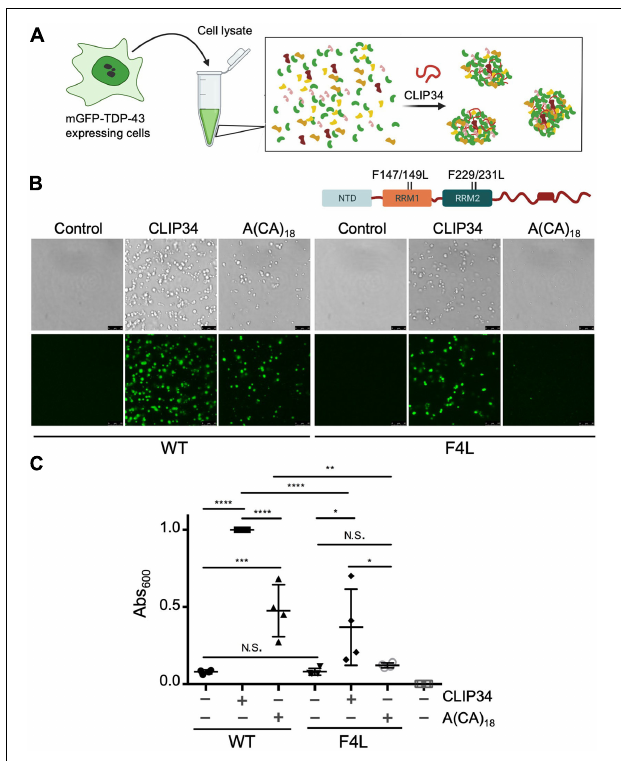
FIGURE 2 | CLIP34 RNA promotes TDP-43 condensation in a cellular lysate. (A) Cell lysates prepared from HEK293 cells stably expressing a single mGFP-tagged copy of either wild-type (WT) or F147/149/229/231L (F4L) TDP-43. Recombinant TDP-43 (WT or F4L, 5.3 µ M) was added to the cell lysate at 250 mM NaCl, pH 7.5. Samples were mixed with CLIP34 (7.6 µ M), A(CA) 18 (7.6 µ M), or no RNA control. (B) Condensates were imaged by brightfield and fluorescence microscopy. Representative images of 3 biological replicates from 2 protein preparations. Scale bars, 10 µ m. (C) Phase separation of TDP-43 in cell lysates measured by turbidity in the same experimental conditions as panel B. Mean and SD of 4 biological replicates from 2 recombinant protein preparations. Analyzed by one-way ANOVA [ F (6,21) = 38.51, P < 0.0001]. Sidak’s multiple comparisons test was used to compare selected groups. * P ≤ 0.05 ** P ≤ 0.01, *** P ≤